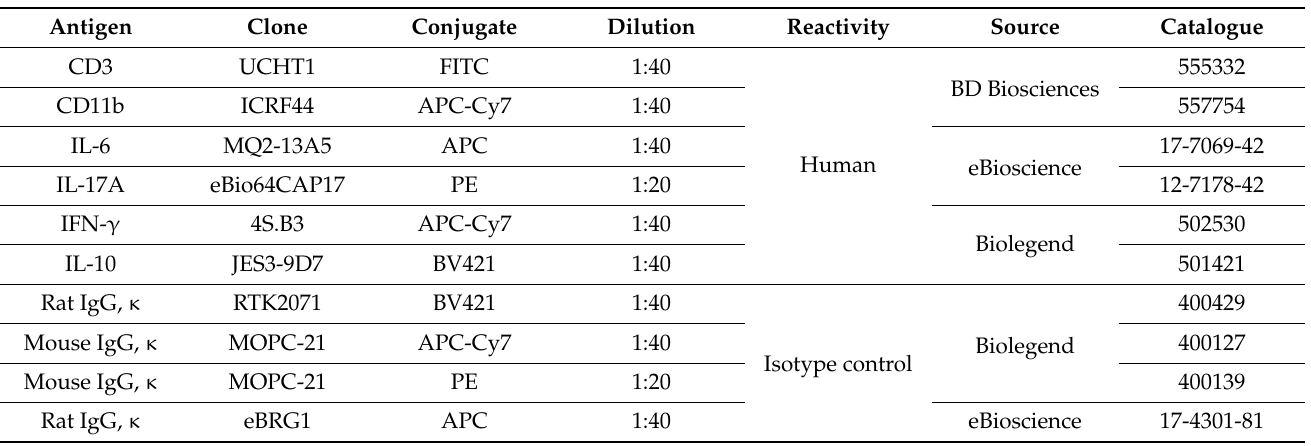
Table 1. Antibodies for flow cytometry and conditions for immunostaining of peripheral blood mononuclear cells